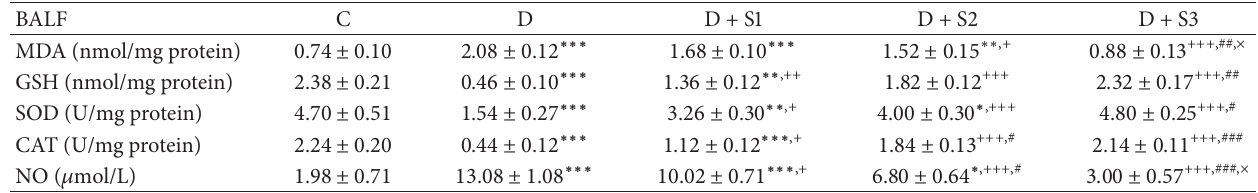
Each measurement has been done at least in triplicate and the values are the means ± SEM for eight rats in each group. Statistical significance for the difference between the data of control versus other groups: ∗ 𝑃 < 0.05 , ∗∗ 𝑃 < 0.01 , ∗∗∗ 𝑃 < 0.001 . Statistical significance for the difference between the data of diabetes versus treated groups: ++ 𝑃 < 0.01 , ++ 𝑃 < 0.01 , +++ 𝑃 < 0.001 . Statistical significance for the difference between the data D + S1 versus D + S2 and D + S3 ( # 𝑃 < 0.05 , ## 𝑃 < 0.01 , ### 𝑃 < 0.001 ). Statistical significance for the difference between the data between D + S2 versus D + S3 ( × 𝑃 < 0.05 ).